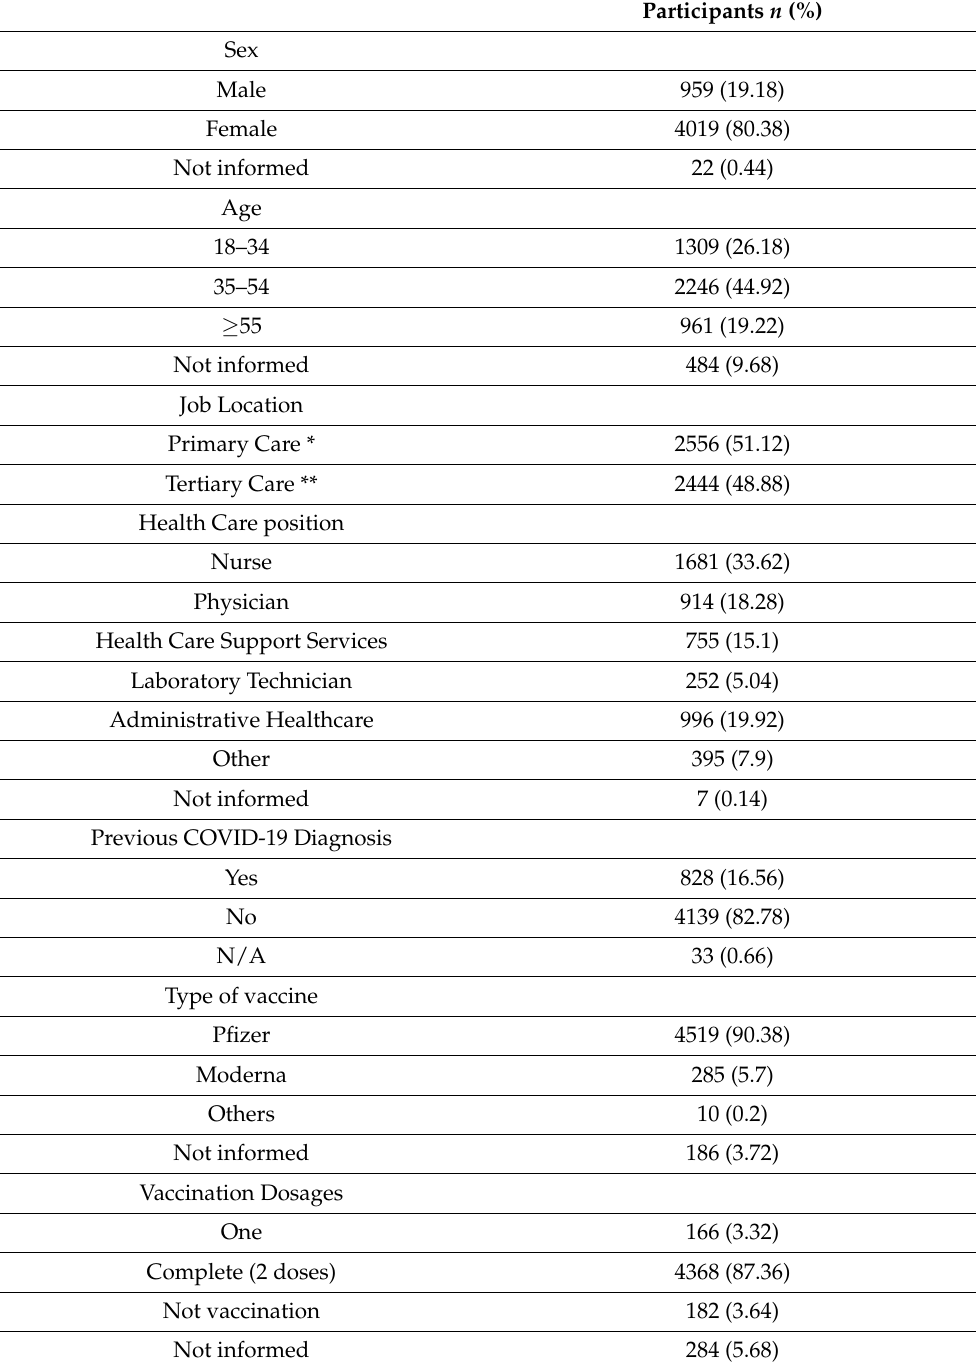
Table 1. Demographic and professional characteristics of the study